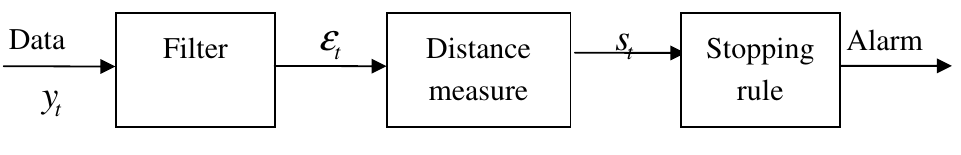
Figure 2. Basic change detection